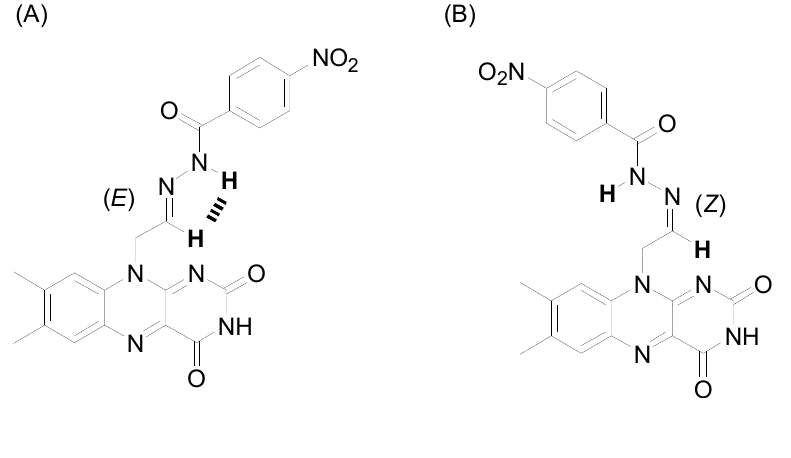
Figure 1. The geometric structures of the product 1 . ( A ) E configuration. ( B ) Z